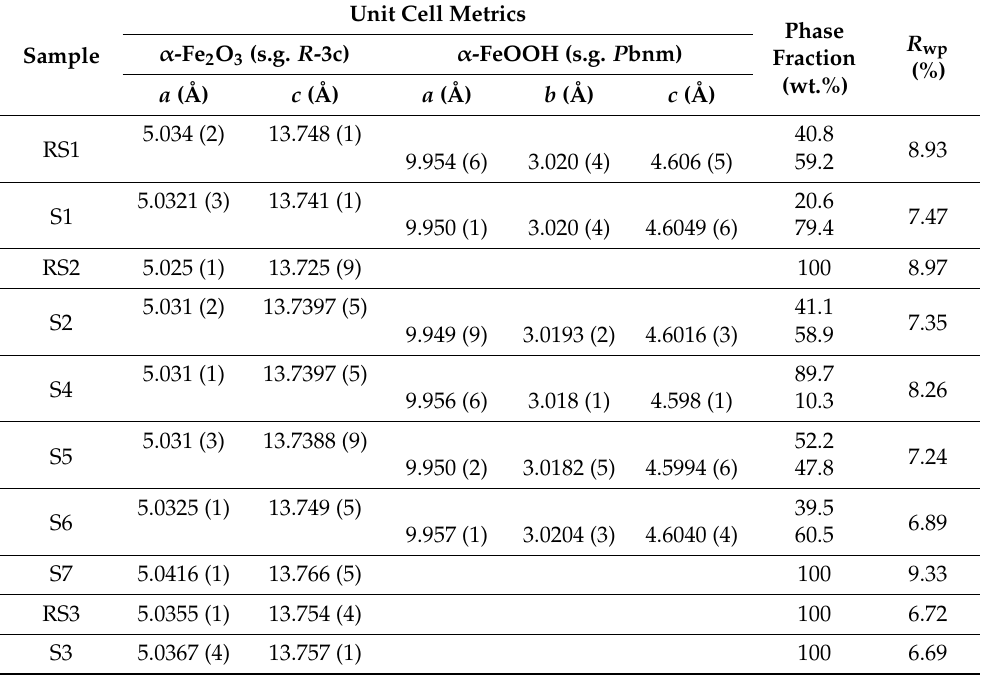
Table 2. Results of semi-quantitative phase analysis as obtained from Rietveld refinement against PXRD data at RT ( λ = 1.5406 Å). R wp is the discrepancy factor that characterizes the quality of the fit [87]. Standard deviations are given in